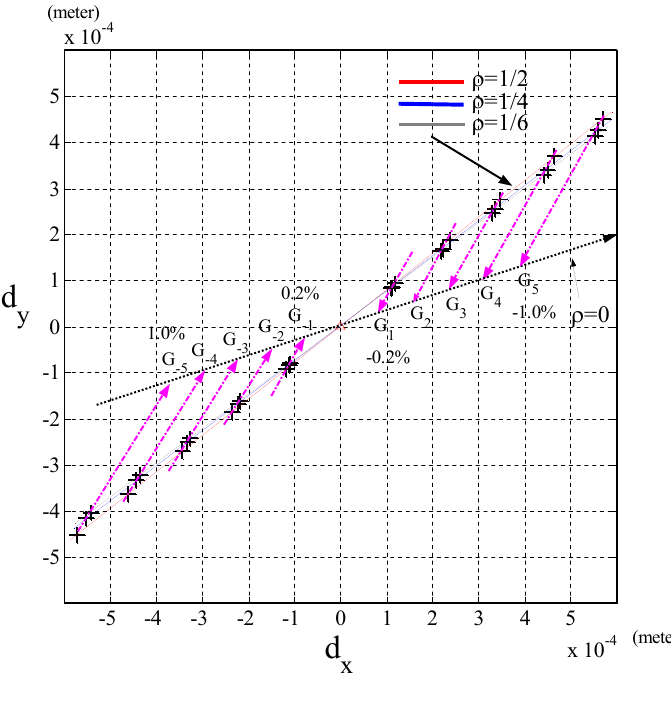
Table 1. Four movement velocities, D/T